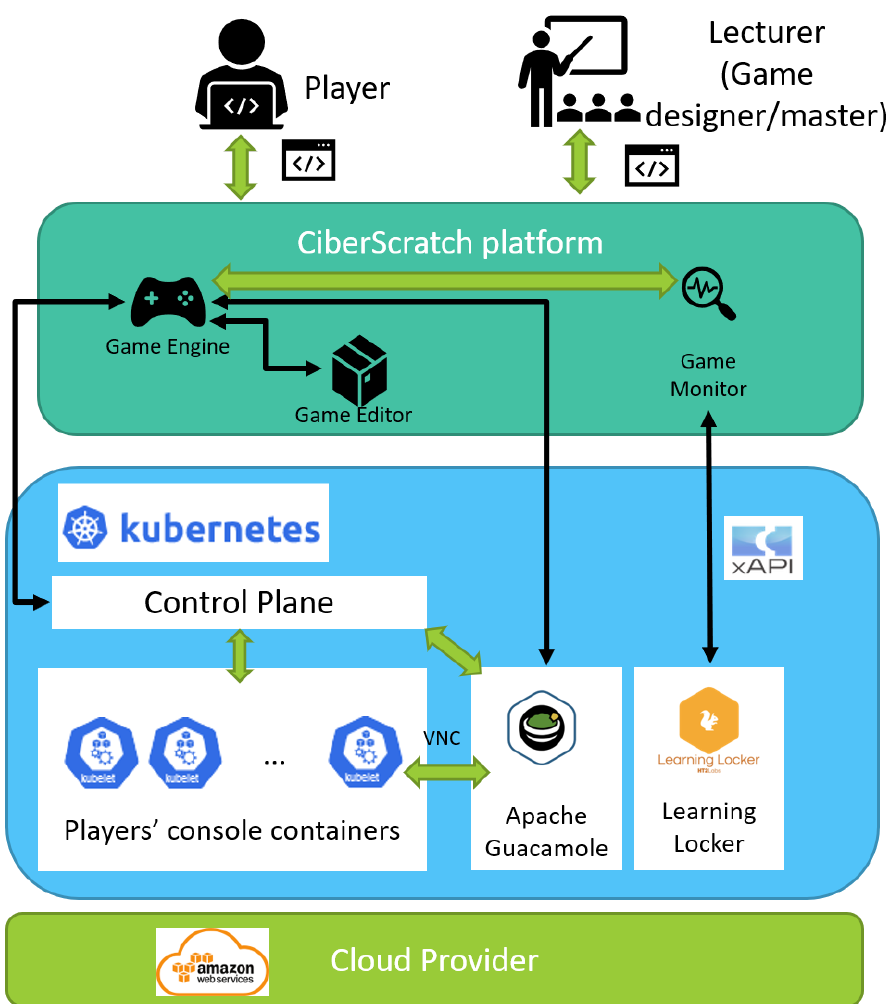
Figure 7. Architecture of our proposed cloud game-based educative